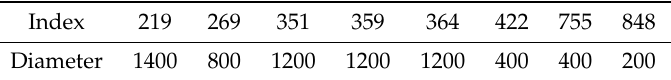
Table 5. The excluded 8 pipes by preliminary hydraulic